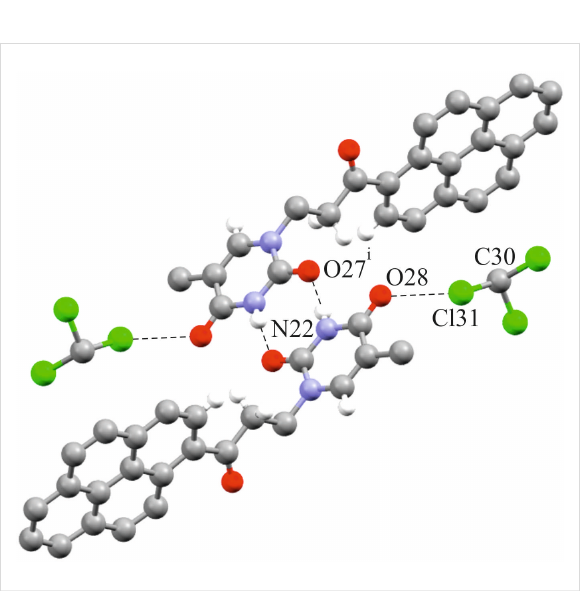
Figure 3: Intermolecular hydrogen bonding (N22–H22···O27 distance = 2.882(2) Å) and halogen bonding (C30–Cl31···O28 distance = 2.972(2) Å) observed in the crystal packing of 2